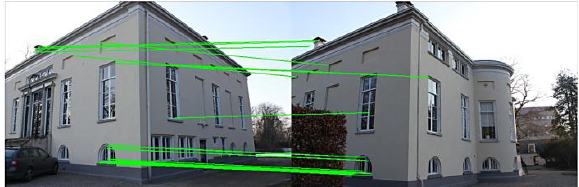
Figure 1. Repetitive texture patterns affecting the matching and leading to wrong correspondences.